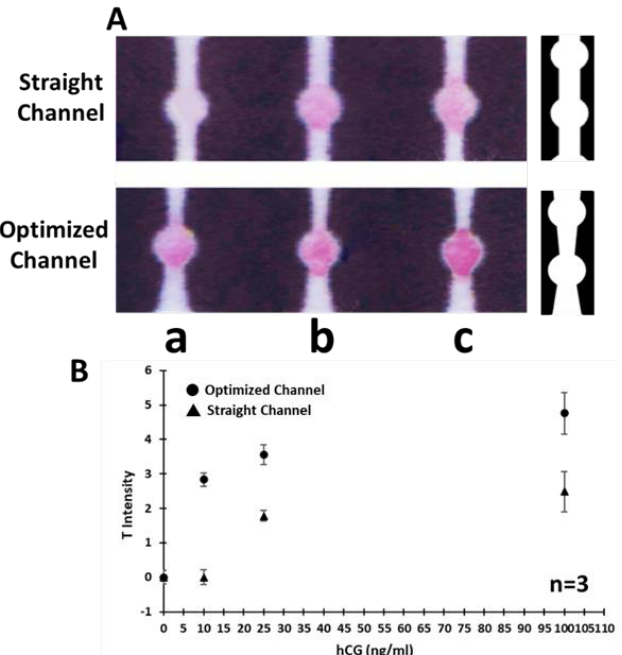
Figure 5. Effect of microfluidic channel geometry on the signal intensity. ( A ) Photographs of µ PADs with straight and optimized channels used for hCG detection in three different concentrations (a: 10, b: 25, c: 100 ng/mL). ( B ) Semi-quantitative image analysis of tested µ PADs indicating the enhancement in signal intensity after optimization of design. The error bars represent the standard deviations corresponding to the average values (n = 3).